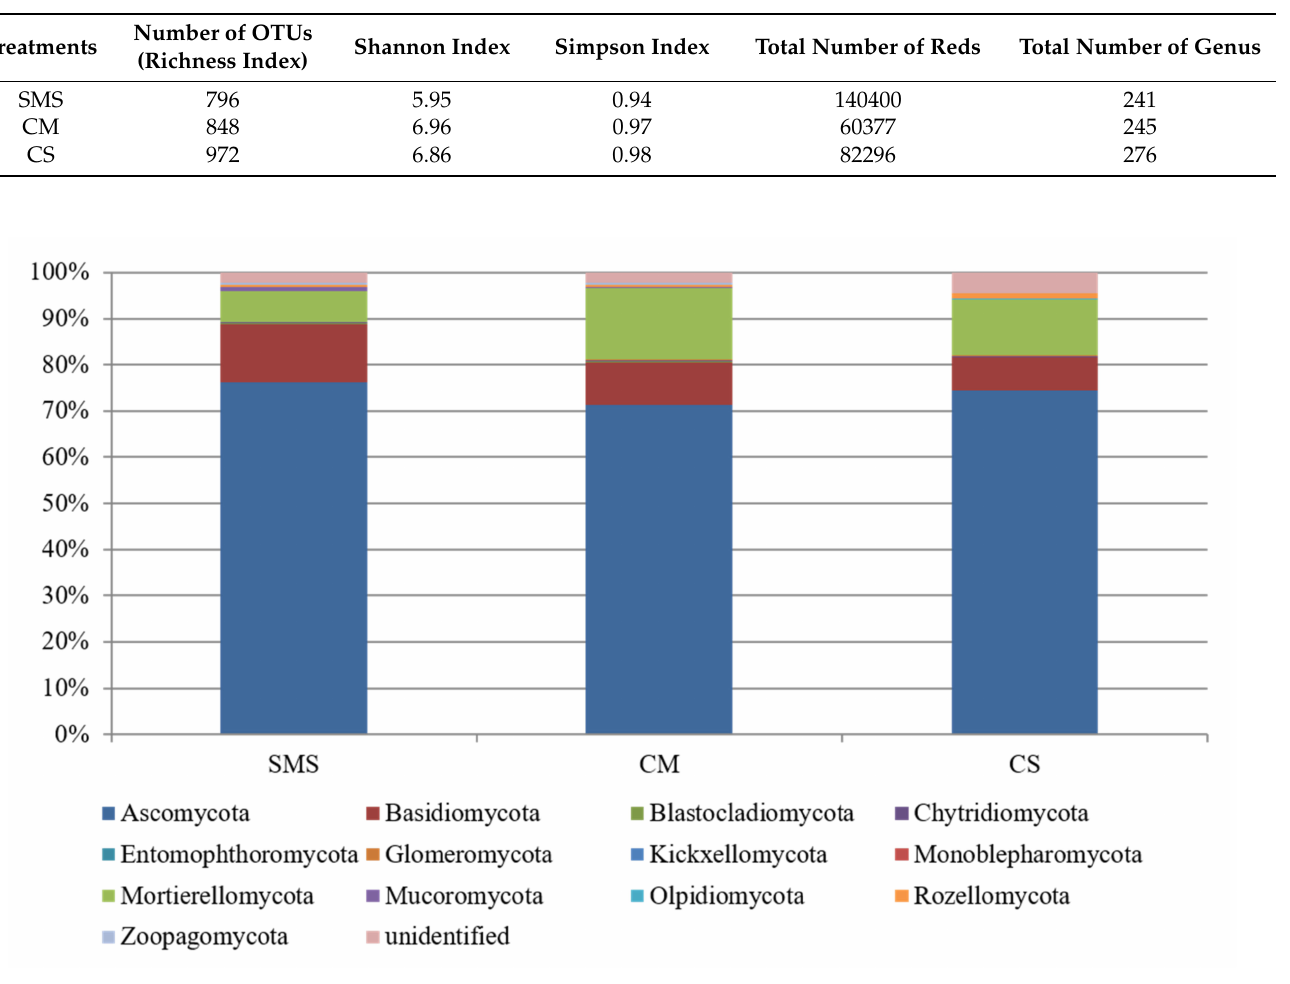
Figure 5. The relative abundance of the soil fungal phylum after the long-term organic treatment. SMS, spent mushroom substrate; CM, chicken manure; CS, control soil. The fungal communities were examined through the next-generation sequencing (NGS) of the ITS1 region using Illumina MiSeq